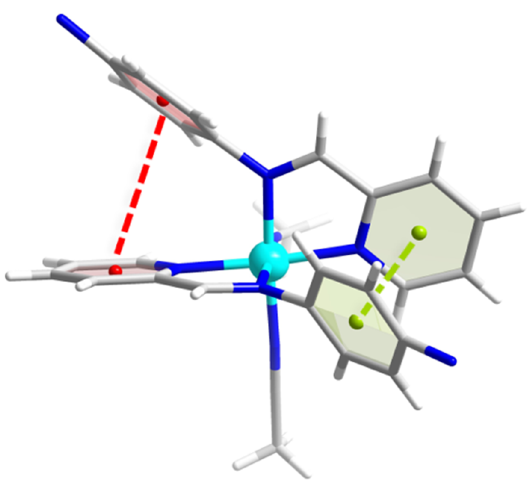
Figure 2. Face-to-face π – π stacking between pyridyl and phenyl groups of adjacent ligands in the series of complexes 1 – 5 (complex 2 depicted). Increased imine-phenyl torsional twisting produces shorter centroid . . . centroid distances.